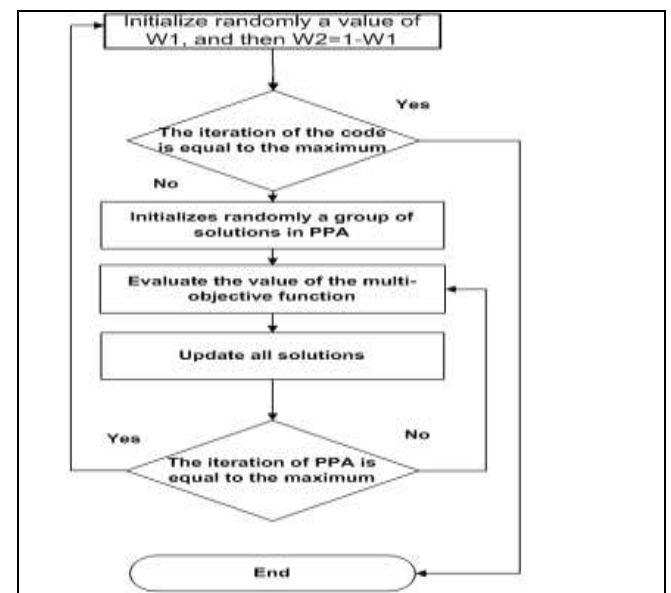
Figure 4. The flowchart for the optimization procedure.